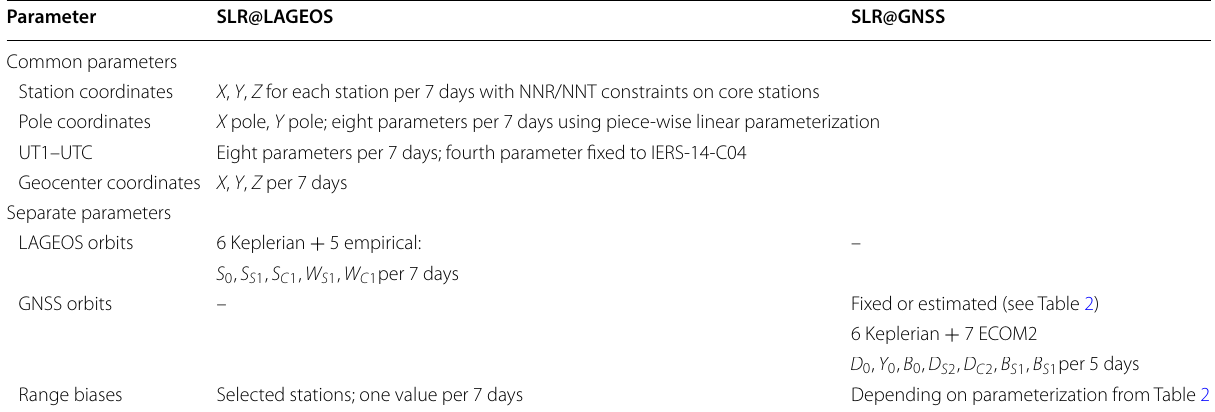
Table 1 List of estimated parameters